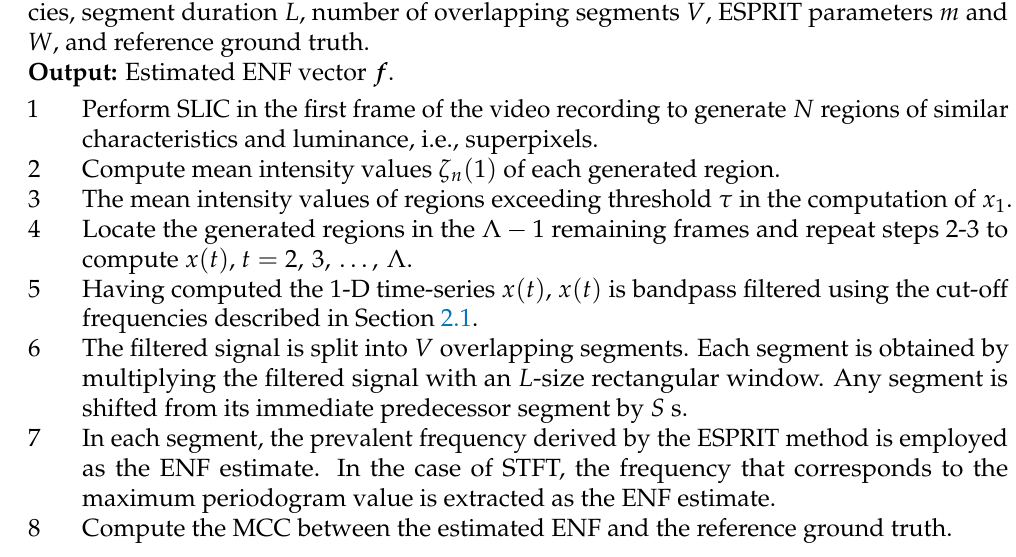
Algorithm 1 Proposed SLIC-based approach for ENF estimation in video